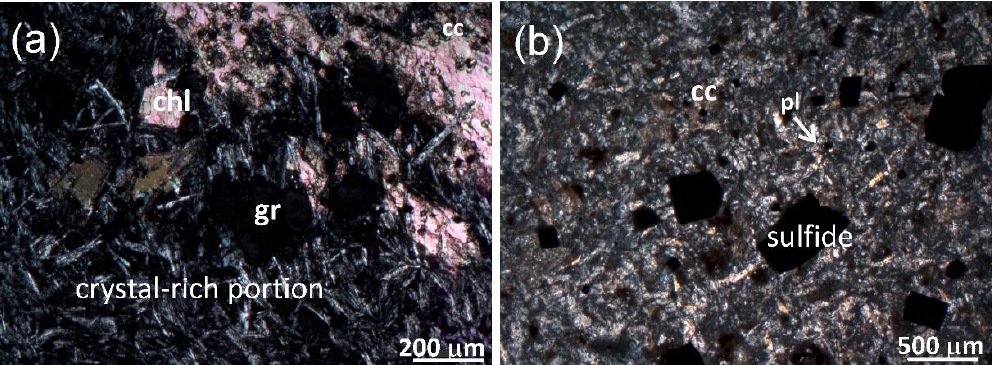
Figure 4. The cored reservoir rocks under the cross-polarized light of the optical microscope: ( a ) the chaotic tuff (representing the modeled Campanian Ignimbrite formation) cored at 1713 m of depth from the propylitic calcium–aluminum–silicate facies in the San Vito 1 borehole (refer to Figure 2a for the downhole location and aspect of the core) and ( b ) the lavas cored at depths of 1500 m from the phyllic facies in the Mofete 1 borehole. ( a ) The San Vito 1 chaotic tuff consists of a low vacuolar and locally crystalline matrix; it presents widespread calcite and chlorite set in the intergrains and shows secondary garnet crystals. ( b ) The Mofete 1 lavas show a highly crystalline matrix with several percent of sulfides and void-filling calcite; the plagioclase microcrysts are altered. Abbreviations: pyroxene; pl, plagioclase; chl, chlorite; cc: calcite; gr: garnet. The plane-polarized image of the San Vito 1 and Mofete 1 cores are in Figure S1. Refer to the text for additional details.